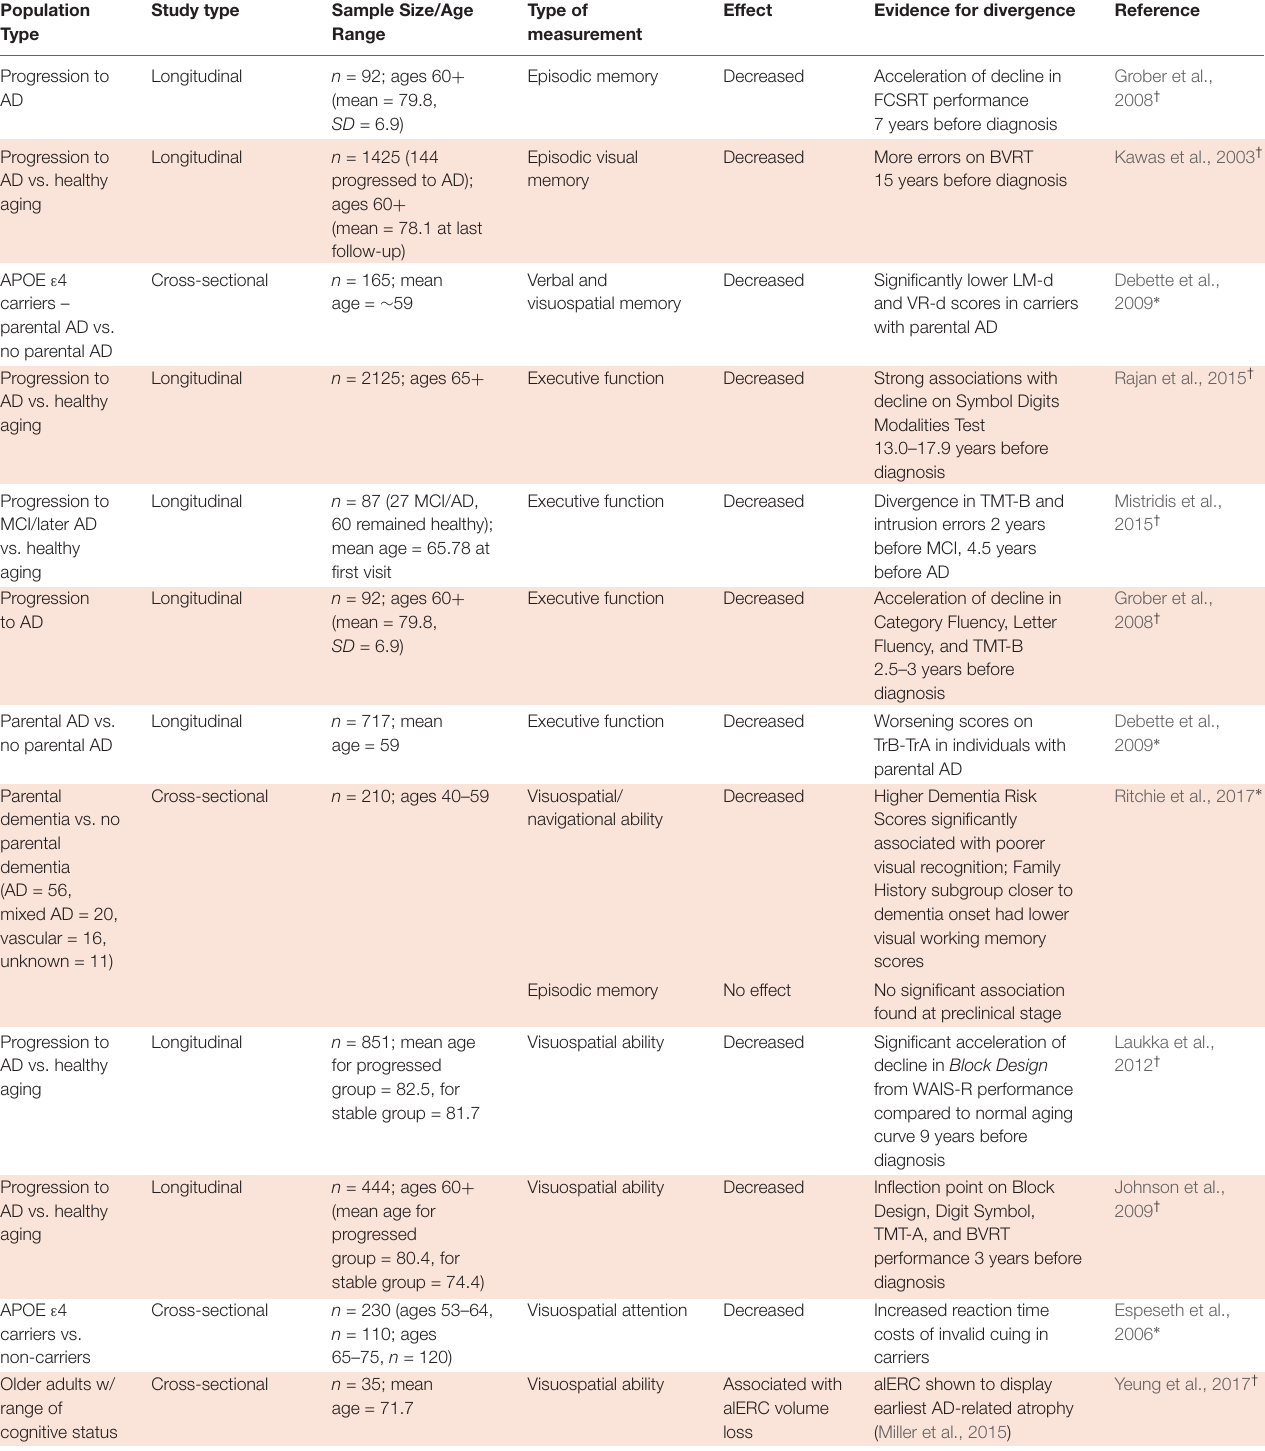
TABLE 2 | Divergence of healthy and pathological aging in cognitive